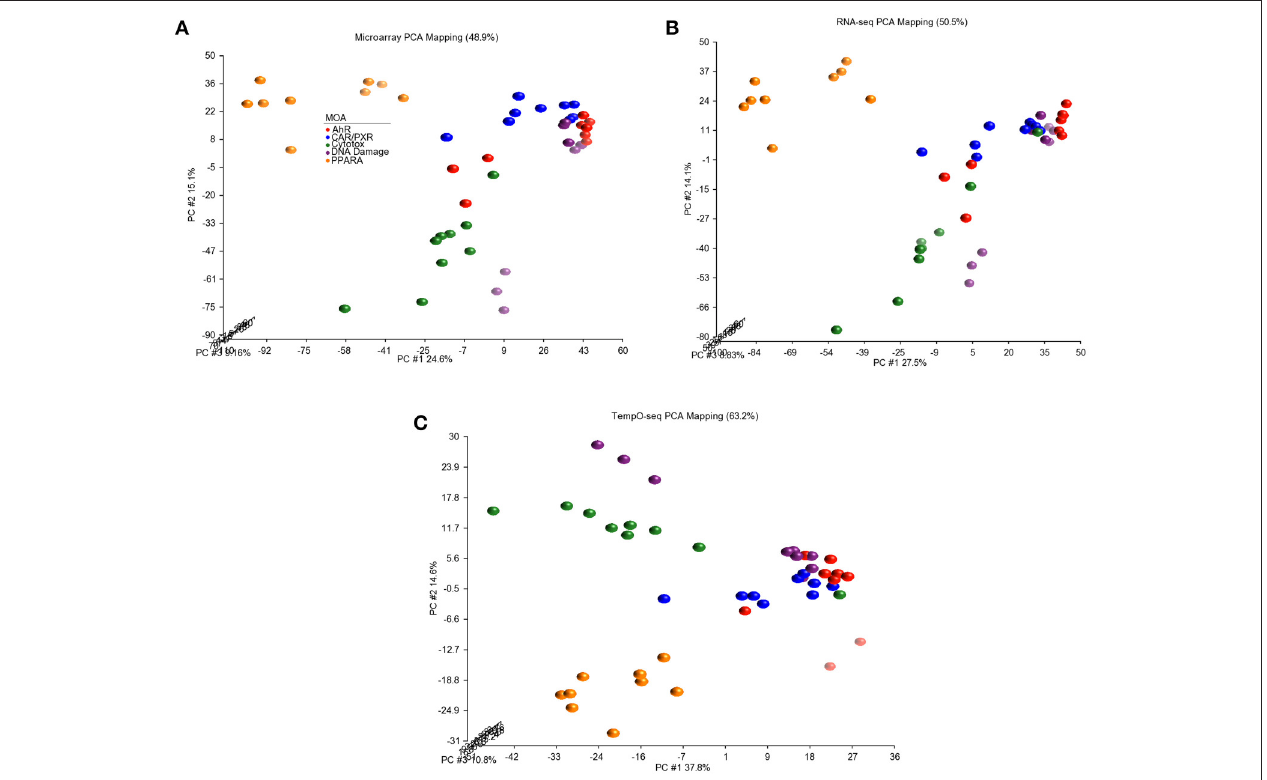
FIGURE 4 | Principal component analysis of the data. (A) Microarray. (B) RNA-Seq. (C) TempO-Seq. PCA performed using the log 2 ratio expression data (treated to matched control according to nutritional status) of the genes that vary by MOA at FDR < 0.01.